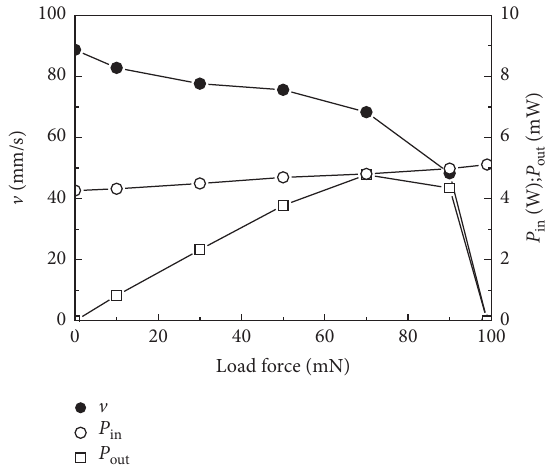
pp . (a) Stall force- V pp . (b) Average velocity- V pp .